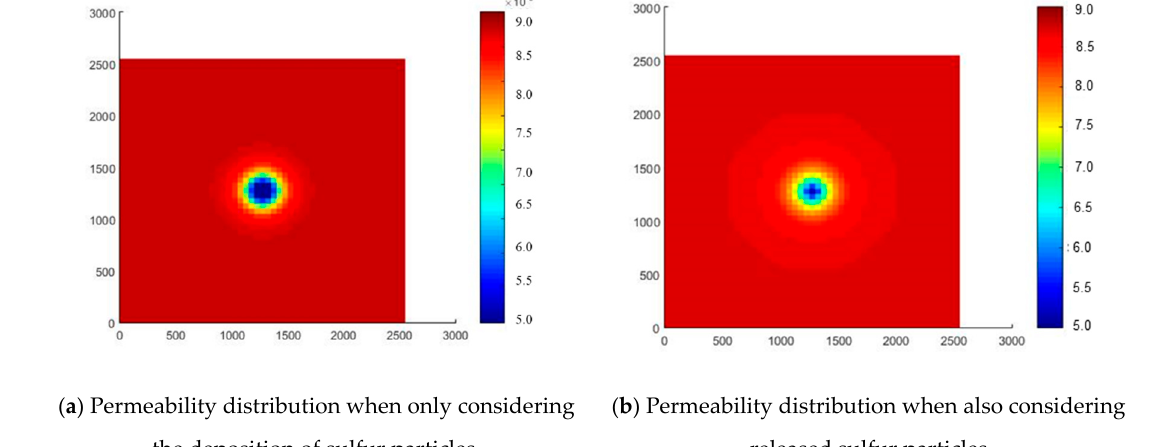
Figure 7. Comparison of permeability across the simulated reservoir.